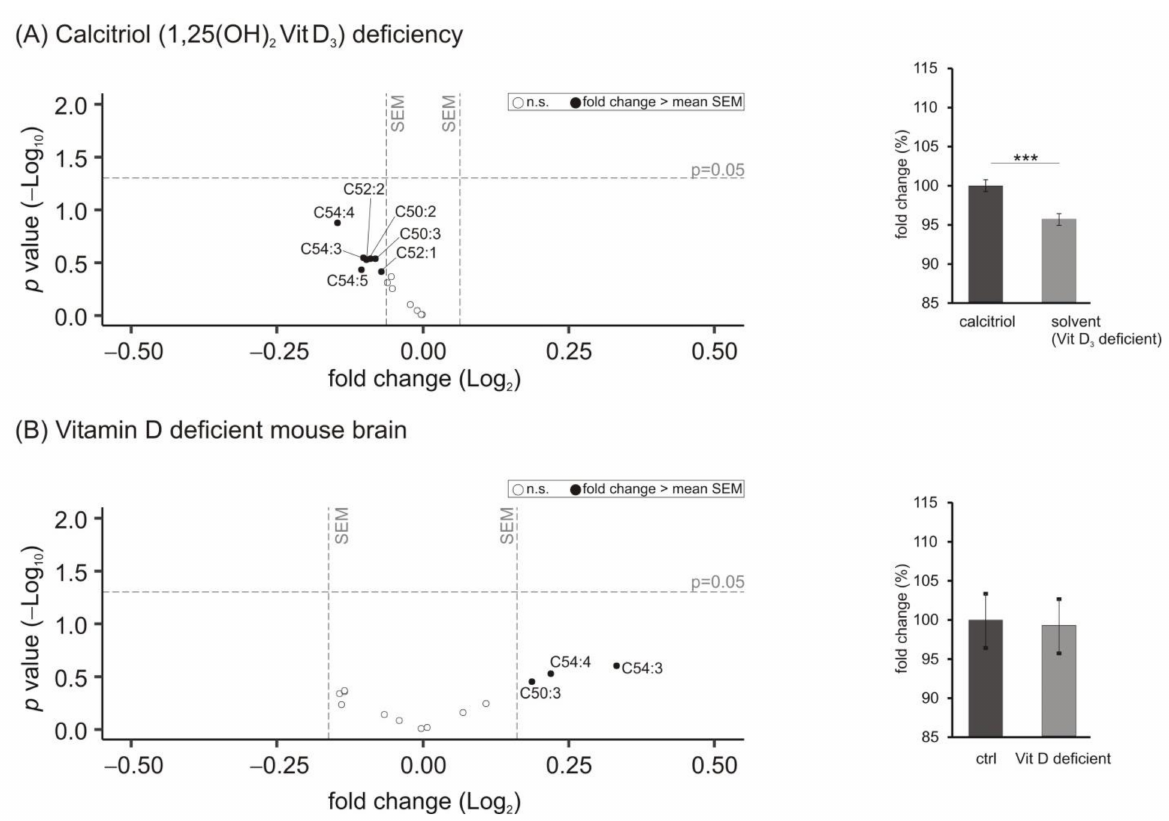
Figure 6. Effect of vitamin D 3 deficiency on triacyl glycerides (TAG) species. ( A ) The levels of TAG in SH-SY5Y wt cells incubated with the solvent control (ethanol) were compared to cells treated with 1,25-dihydroxy vitamin D 3 . In the volcano plot, the fold change ( x -axis) of each of the 14 analyzed TAG species (dots) was plotted against the corresponding p -value ( y -axis). The volcano plots are structured as described in detail in the legend of Figure 1. The bar chart on the right shows the relative fold change of all measured TAG species comparing calcitriol-treated with solvent-control-treated SH-SY5Y cells. ( B ) Analyzed TAG species in brain samples of vitamin D deficient mice compared to control-fed mice in a volcano plot and relative fold changes of all measured TAG species in a bar chart. Error bars represent the standard error of the mean (SEM). Statistical significance was set as *** p ≤ 0.001; n.s. not